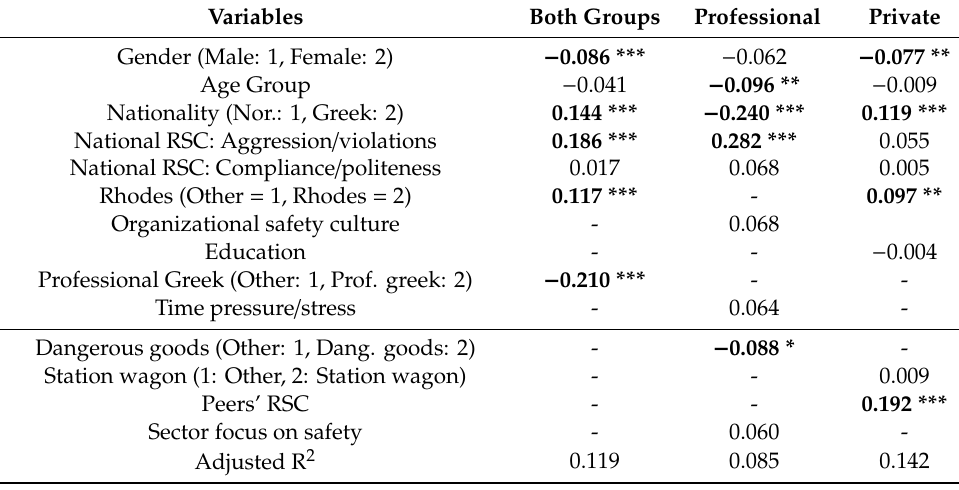
Table 11. Linear regression analyses for three groups. Dependent variable: “Driving when you suspect that your blood alcohol content may be higher than the legal limit”. Standardized beta coe ffi cients.